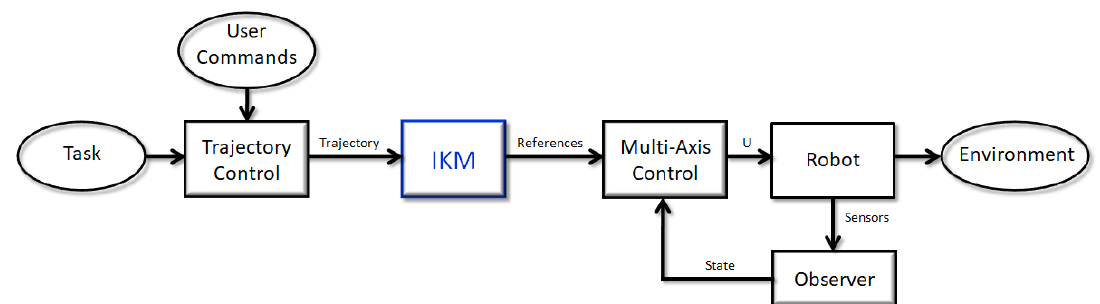
Figure 1. Inverse Kinematic Model (IKM) in the robot’s control system. The IKM’s function is to calculate the required references for the robot’s multi-axis